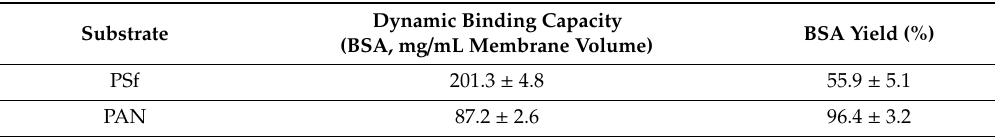
Figure 7. Chromatograms of dynamic protein binding runs using PSf-GMA-DEA with 7 min UV polymerization ( a ), and mPAN-GMA-DEA with 15 min UV polymerization ( b ). Table 1. Productivity comparison for different substrate membranes. Error bars represent the standard deviation of calculated values using data from 2 measurements.